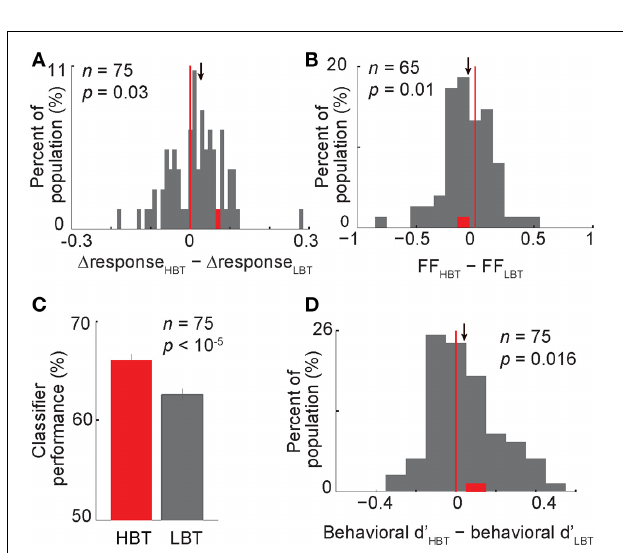
selectivity index. (C) The histogram representing the correlation of baseline and evoked firing rate. Each data point shows the correlation coefficient value for one body neuron. Conventions as described in Figure 2 .